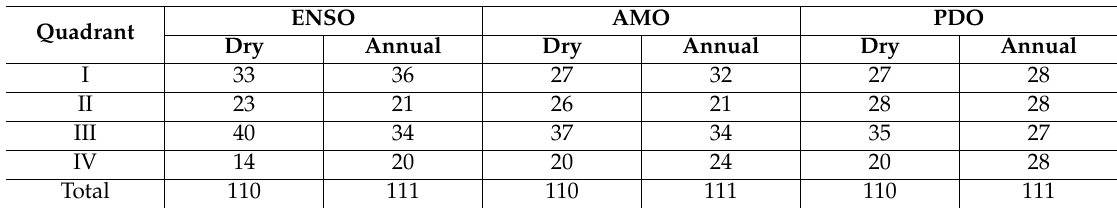
Table 1. Quadrant counts of the overlaps of total annual and dry season rainfall anomalies with cumulative SST anomalies of ENSO, AMO, and PDO. ENSO Quadrant